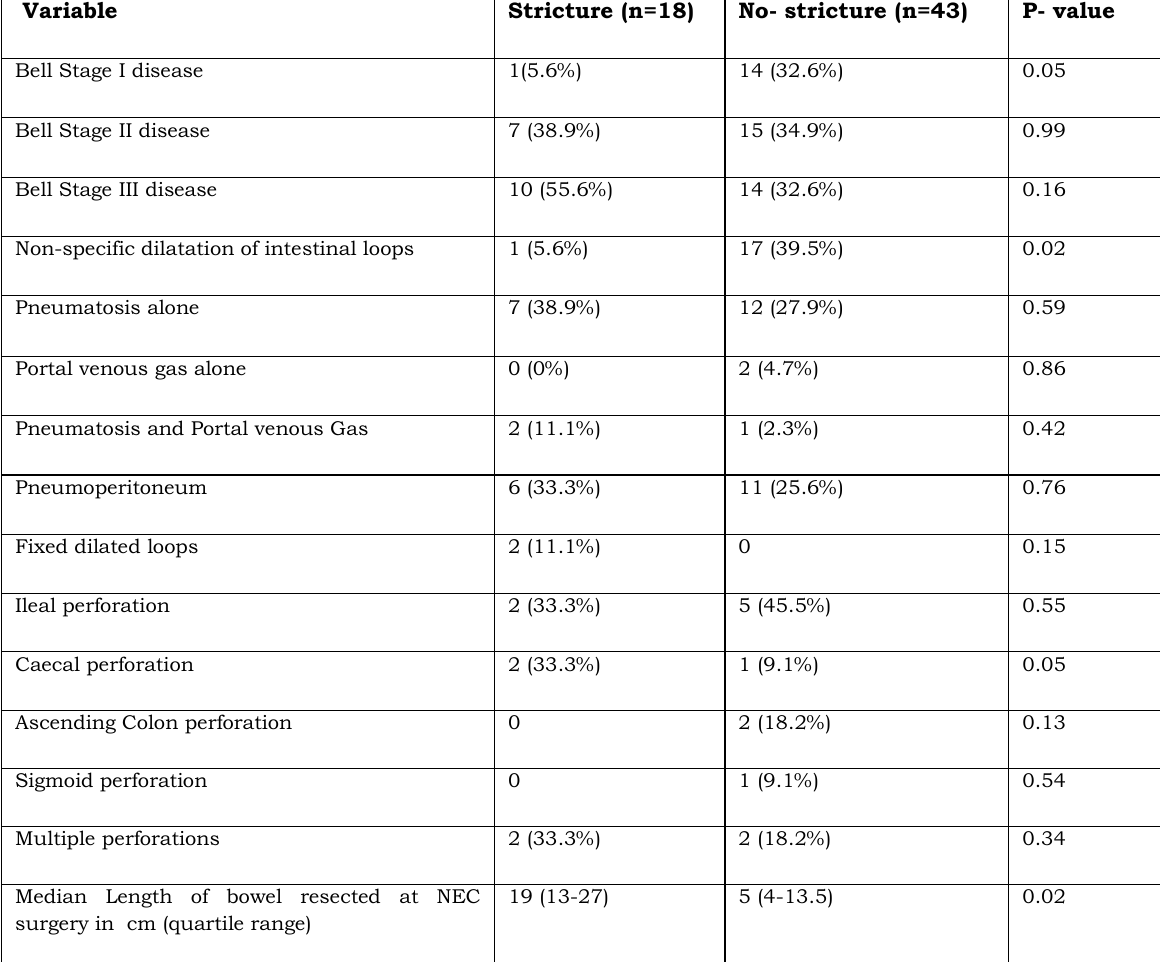
Table 3: Severity of NEC and abdominal x-ray